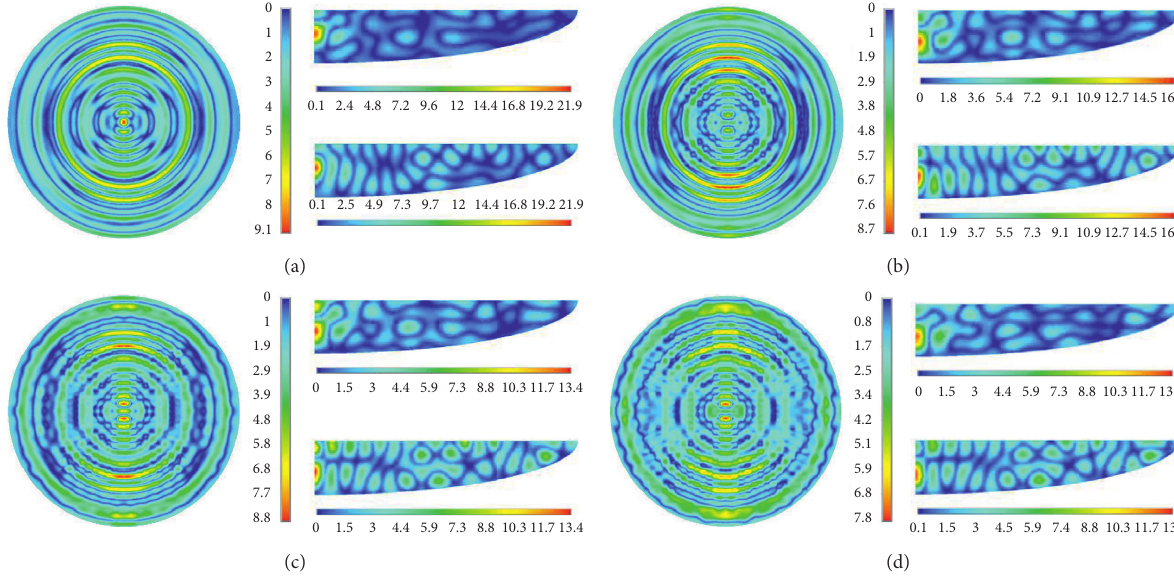
Figure 10: The displacement amplitude of the homogeneous sedimentary basin ( f � 4.0Hz): (a) no buildings; (b) buildings 14 × 14; (c) buildings 20 × 20; (d) buildings 26 × 26.